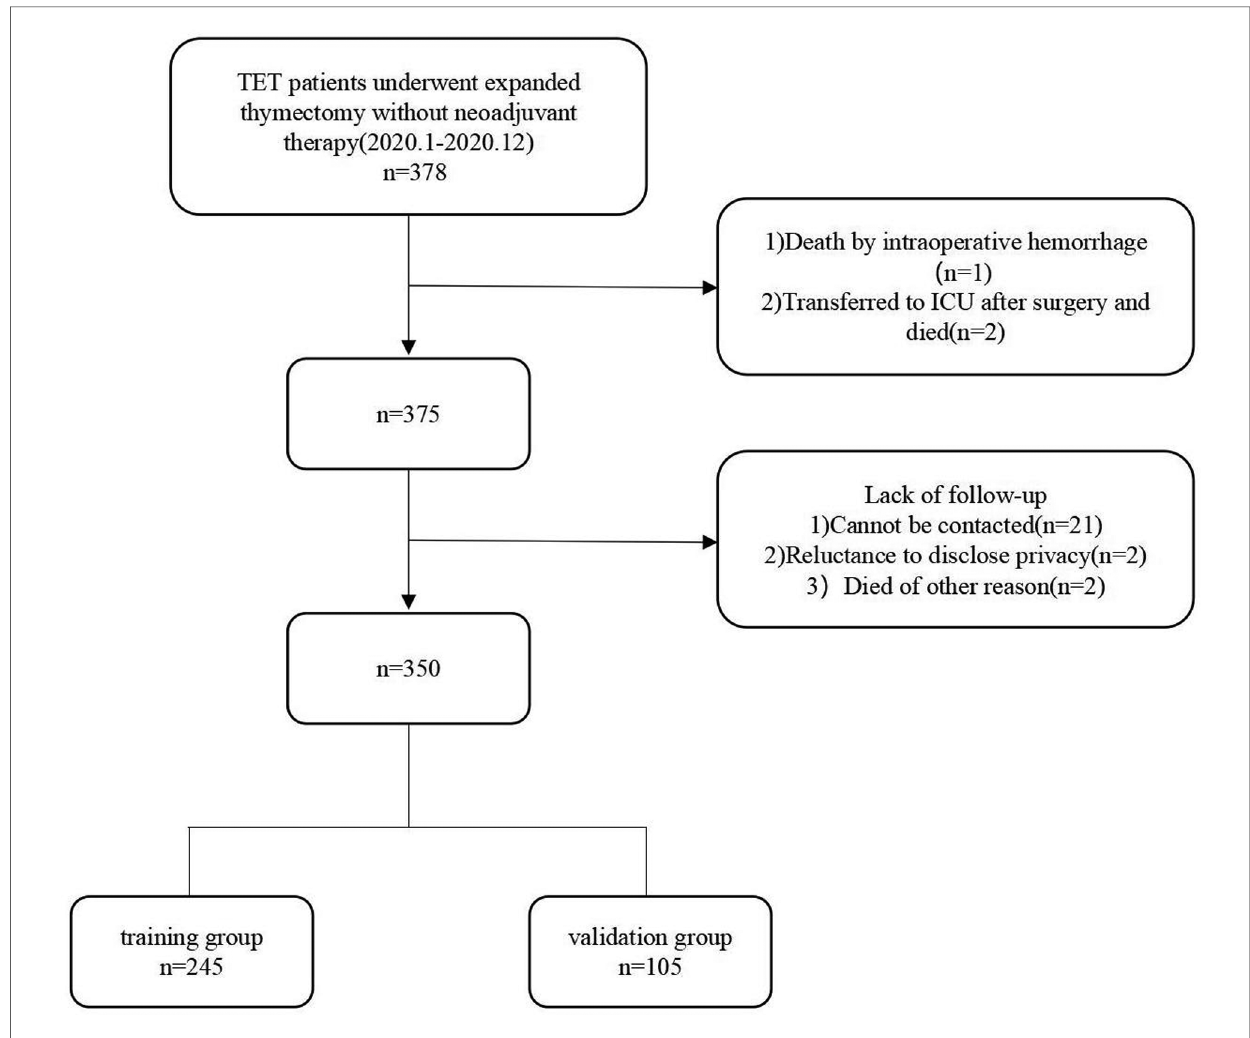
FIGURE 1 The fl ow diagram of the patients enrolled in this study. TET, Thymic epithelial